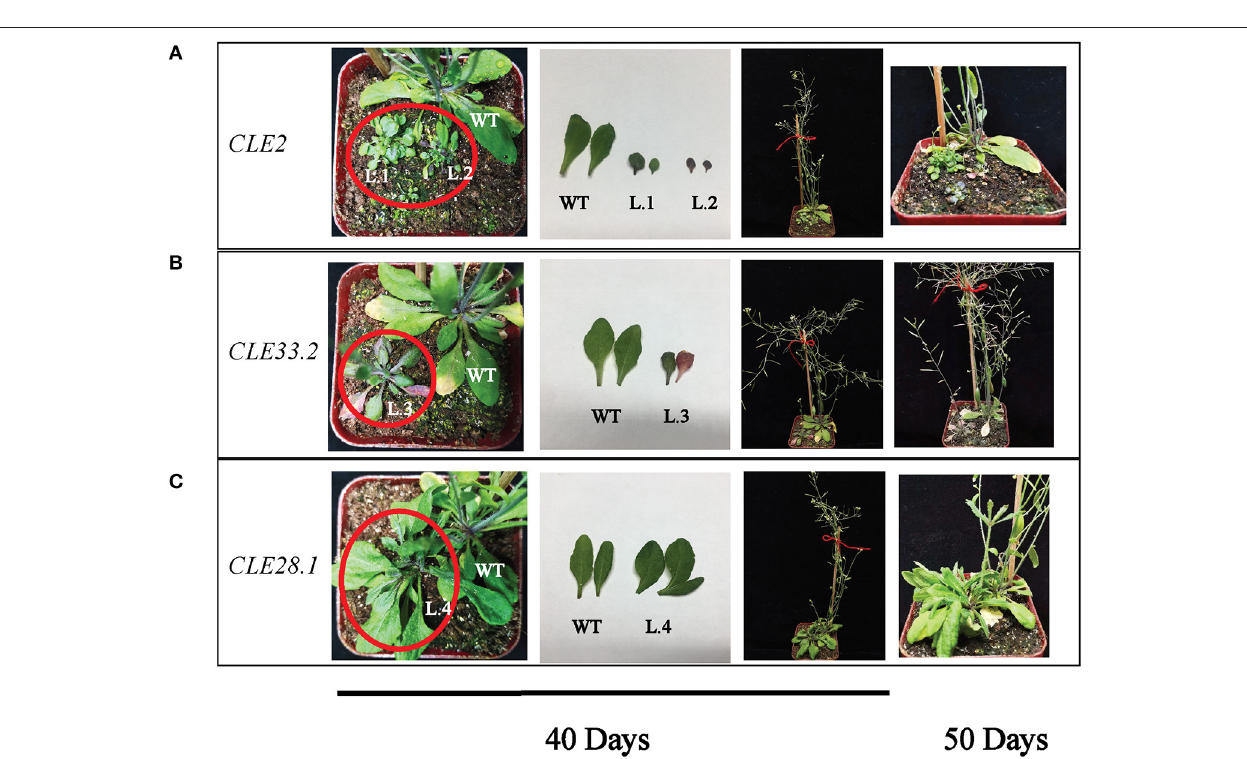
FIGURE 10 | Phenotypes of GhCLE2 (A) , GhCLE33.2 (B) , and GhCLE28.1 (C) overexpressed in Arabidopsis . The pictures of the first three columns show the seedlings and corresponding leaves at 40 days after germination, and the last column shows seedlings at 50 days